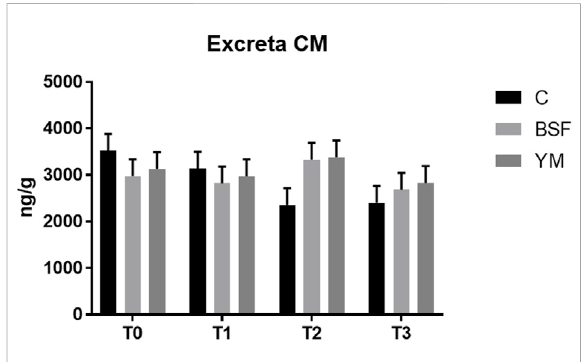
FIGURE 7 Excreta CM of the broiler chickens (diet*time interaction, p > 0.05).C=control group;BSF=Cdiet+blacksoldier fl ylivelarvae; YM=Cdiet+yellowmealwormlivelarvae.T0=day0;T1=day11; T2 = day 22; T3 = day